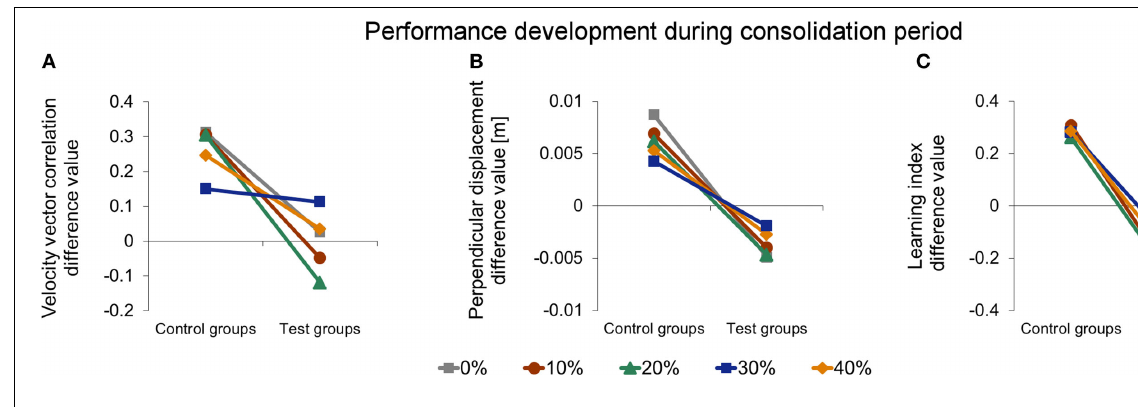
FIGURE 8 | Comparison of development in initial performance from learning session (day 1) to retest (day 3) of force field A measured by velocity vector correlation (A), perpendicular displacement (B), and learning index (C). Positive values indicate a performance improvement, whereas negative values indicate a decreased initial retest performance compared to naive performance. In general, test groups show impaired consolidation compared to corresponding control groups indicated by a